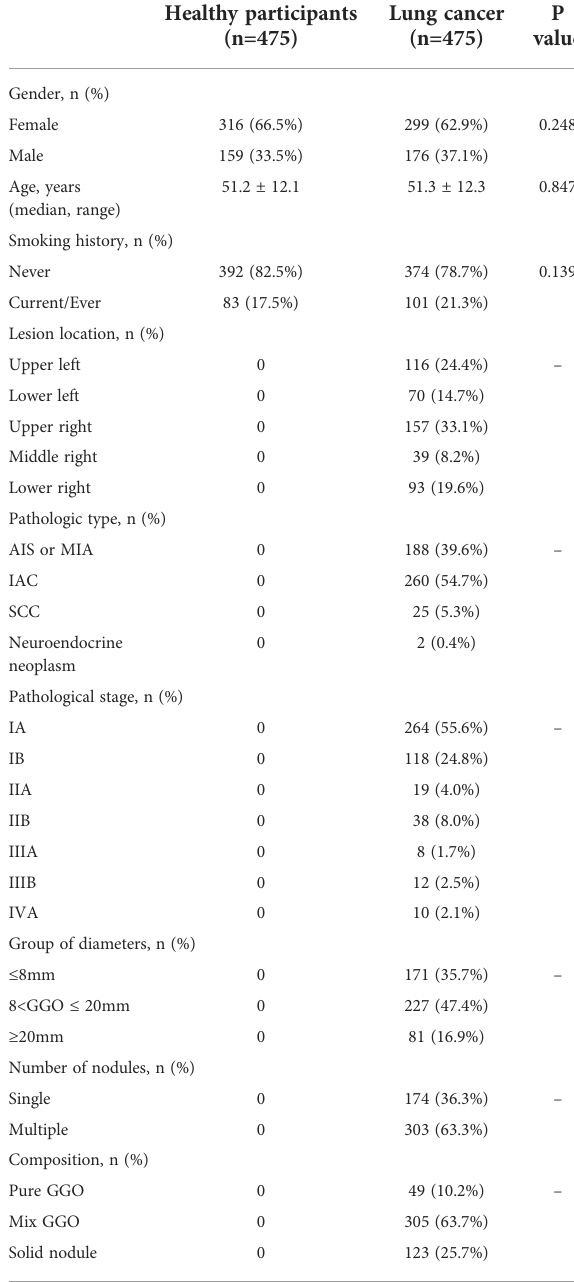
TABLE 1 Baseline clinical characteristics of patients in the training